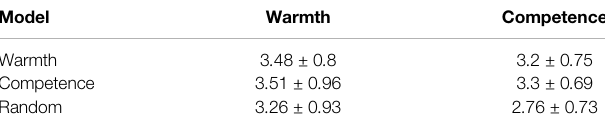
TABLE 1| Meanandstandarddeviationof w and c scoresforeachlevelofModel.